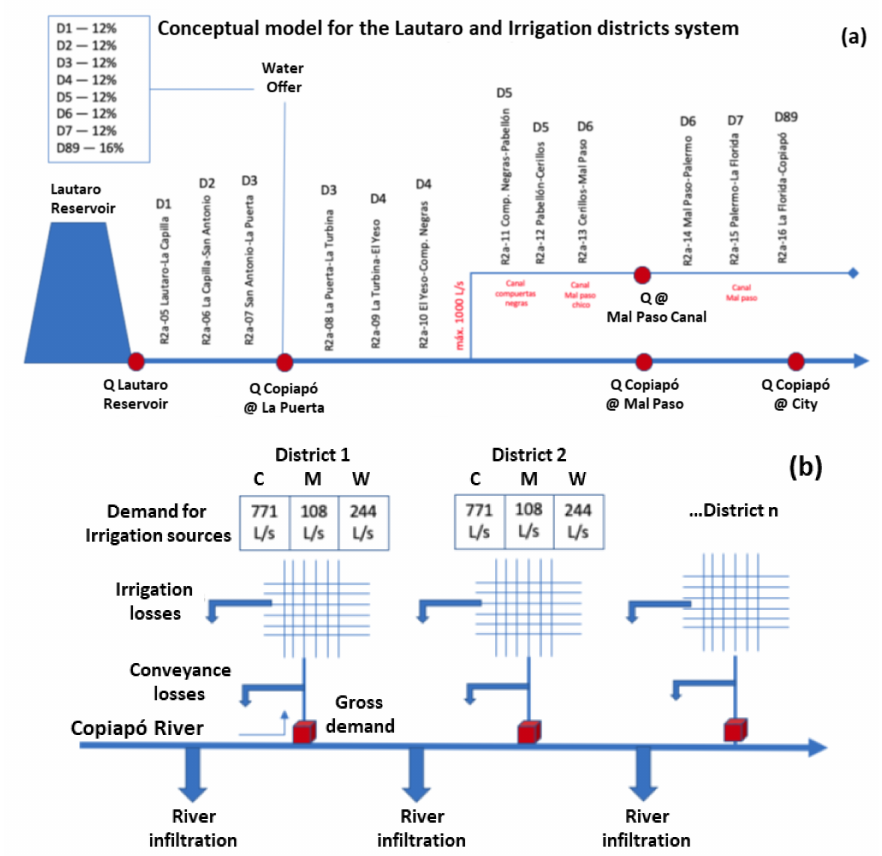
Figure 4. Conceptual model for the ( a ) operation of the Lautaro Reservoir and the ( b ) irrigation districts in the Copiap ó River Basin. Values for parameters of the conceptual model are obtained from [39,40] and included in the node–link water balance model. Water sources for each irrigation district are distinguished between C: channel, W: wells and M: mixed source and are based on crop area supplied by that